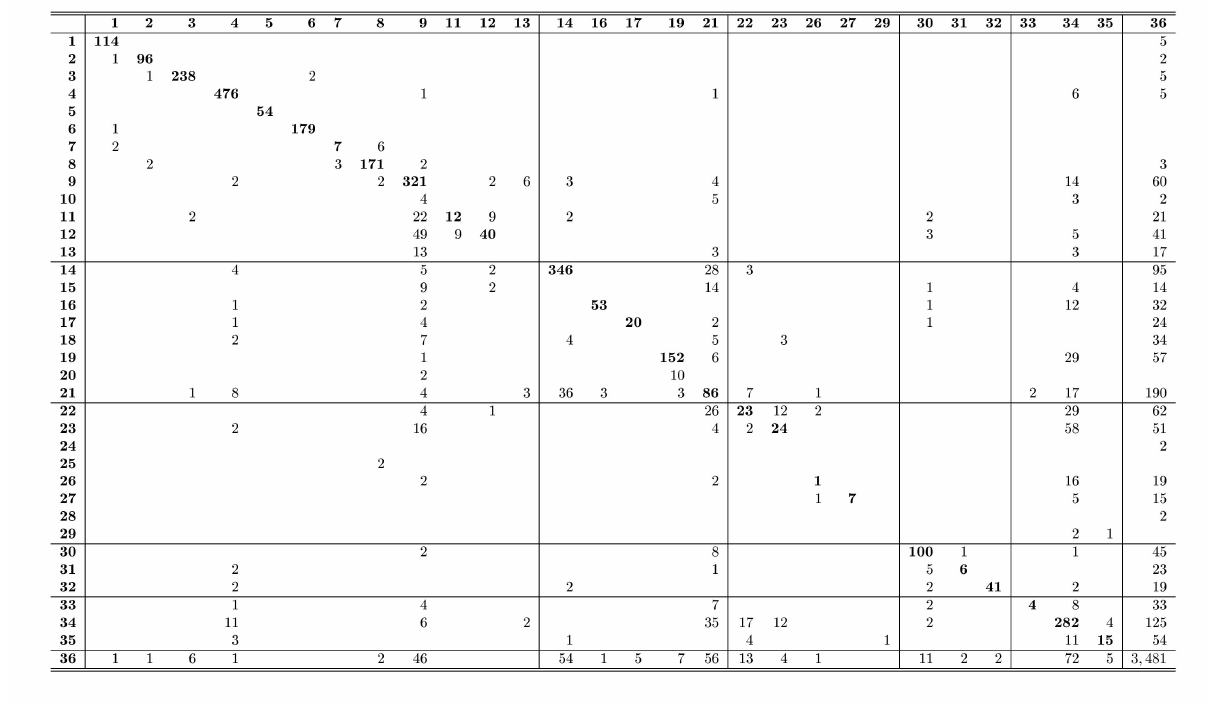
Figure 6. Confusion matrix between the reference standard (rows) and our best information extraction system (columns) in the 36-class multi-class classification task. Zero columns of 10, 15, 18, 20, 24, 25, and 28 have been removed for space constraints. For clarity, diagonal elements have been emphasized, and zero elements have been left empty. The category numbering corresponds to Figure 2. IE: information